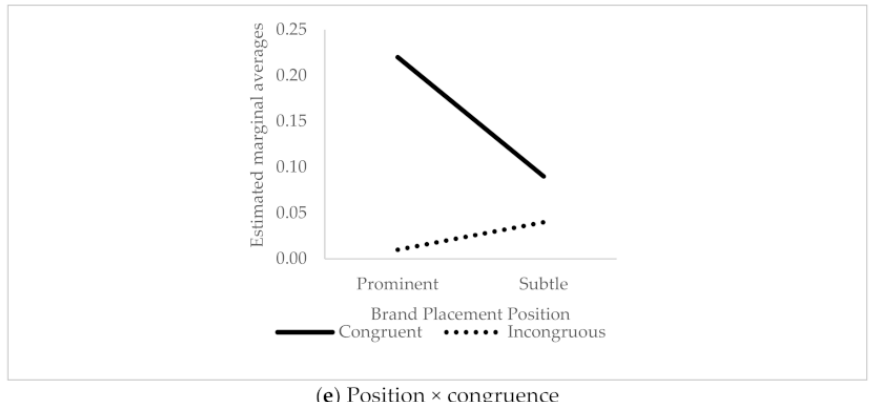
Figure 2. Recall measurements for each of the experimental conditions: ( a ) position × familiarity, ( b ) congruence × familiarity, ( c ) for familiar brands, position × congruence, ( d ) for unfamiliar brands, position × congruence, ( e ) position × congruence.